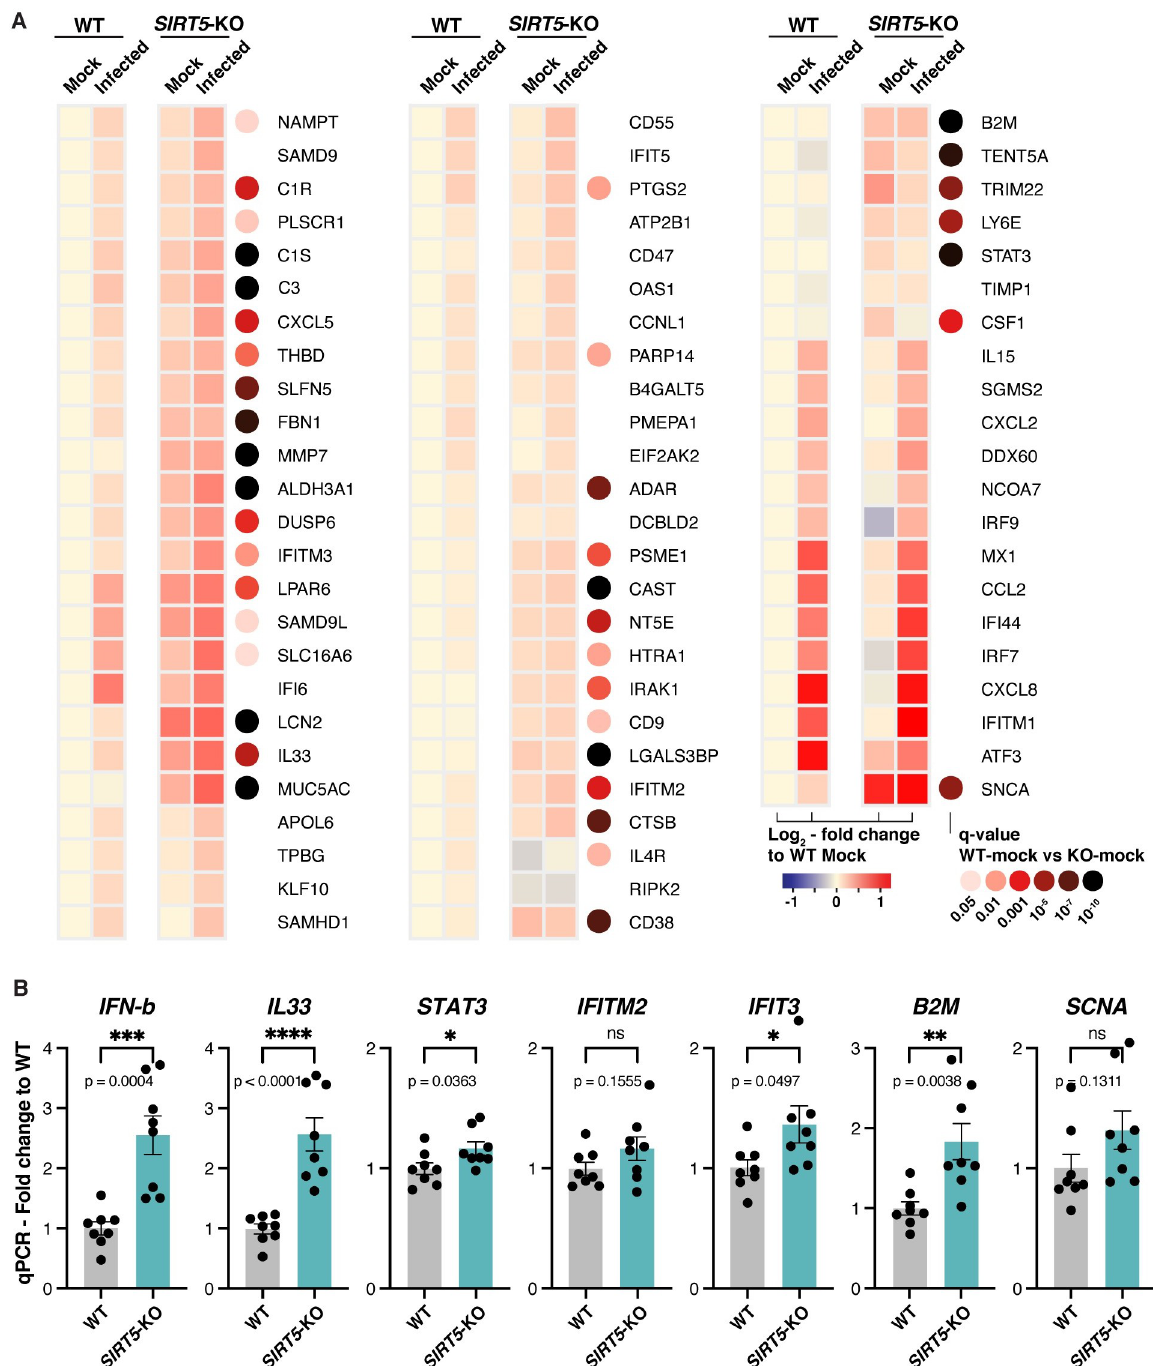
Fig 7. SIRT5 -KO cells express a higher basal level of viral restriction factors. A . Expression heatmap of interferon-stimulated genes and other restriction factors, showing that mock-infected SIRT5- KO cells express higher basal levels of restriction factors, and that antiviral responses are stronger in SIRT5- KO cells. Data show mean log2 fold-change, compared to mock-infected WT, and the q-value between mock-infected WT and SIRT5- KO cells. Only genes differentially expressed between at least two conditions were included in the analysis (q < 0.01). B . RT-qPCR confirmation of restriction factors upregulated in non-infected SIRT5- KO cells (n = 8). Data show fold-changes compared to WT levels after normalization with ACTIN . Data show mean and SEM between replicates. p-values after unpaired two-tailed t-test are shown and asterisks summarize the results. � : p < 0.05, �� : p < 0.01, ��� : p < 0.001, ���� : p < 0.0001.